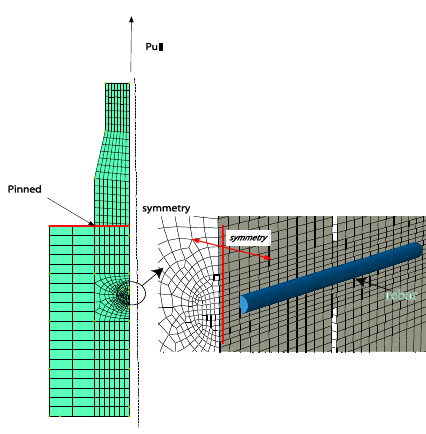
Figure 10. Finite element (FE) model.